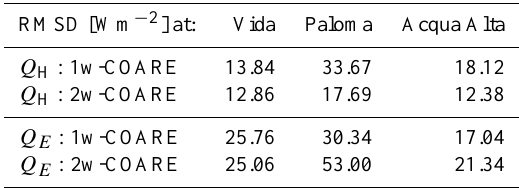
Table 1. Root mean square differences (RMSD) between modeled ALADIN fluxes (modified Louis scheme) and fluxes from in situ observations (COARE